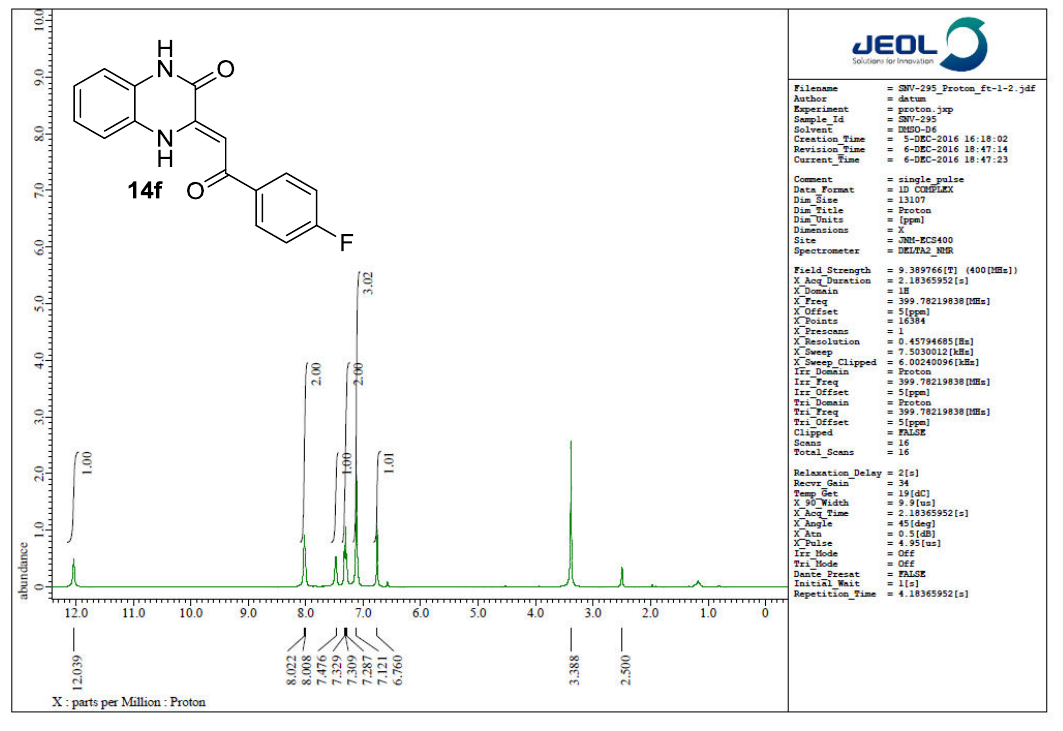
Figure 39 . 1 H NMR Spectra of Compound 14f .